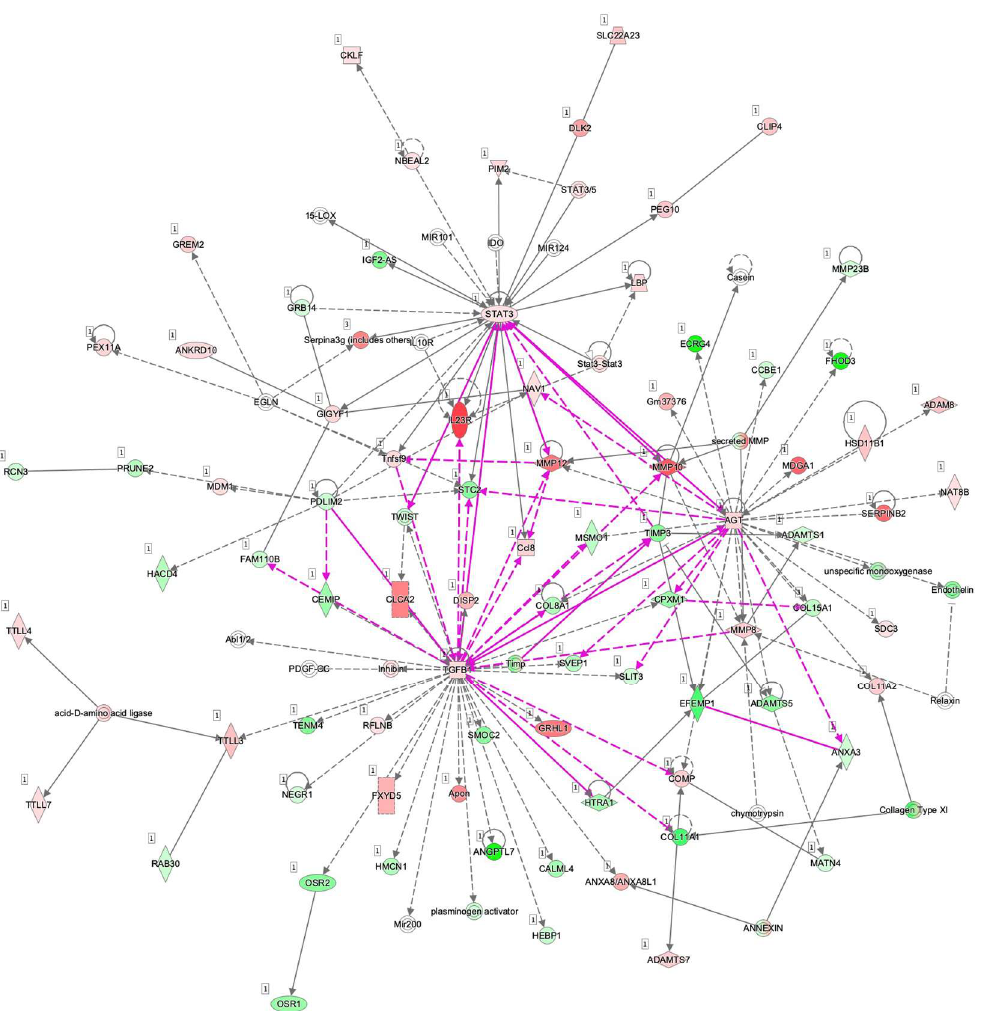
Figure 8. Merged causal networks related to AGT (network 5), STAT3 (network 7), and TGF 1 (network 10). Prediction legend is shown in Figure S1. Table 1. Lists of the top 14 causal networks of diseases and functions with IPA network score of more than 30.